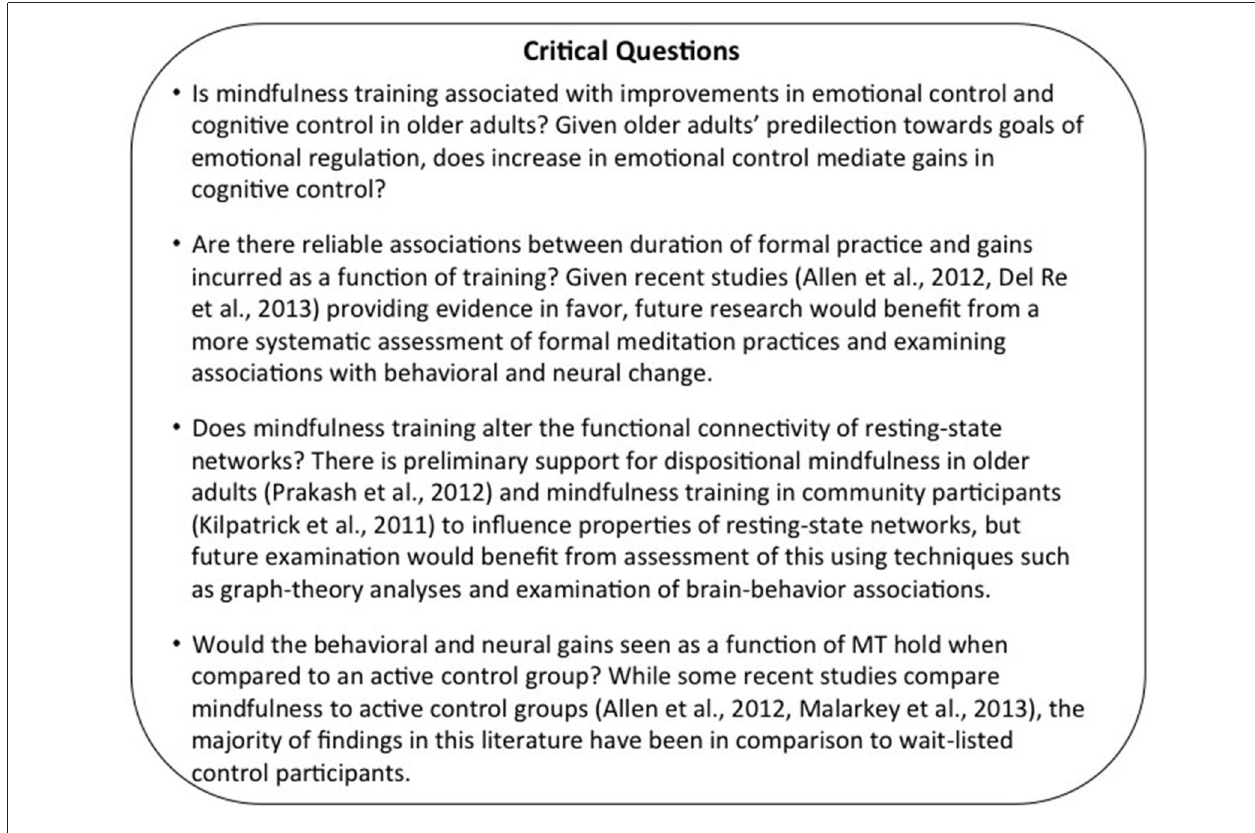
FIGURE 3 | Highlights the key points from the section on Future Directions and Key